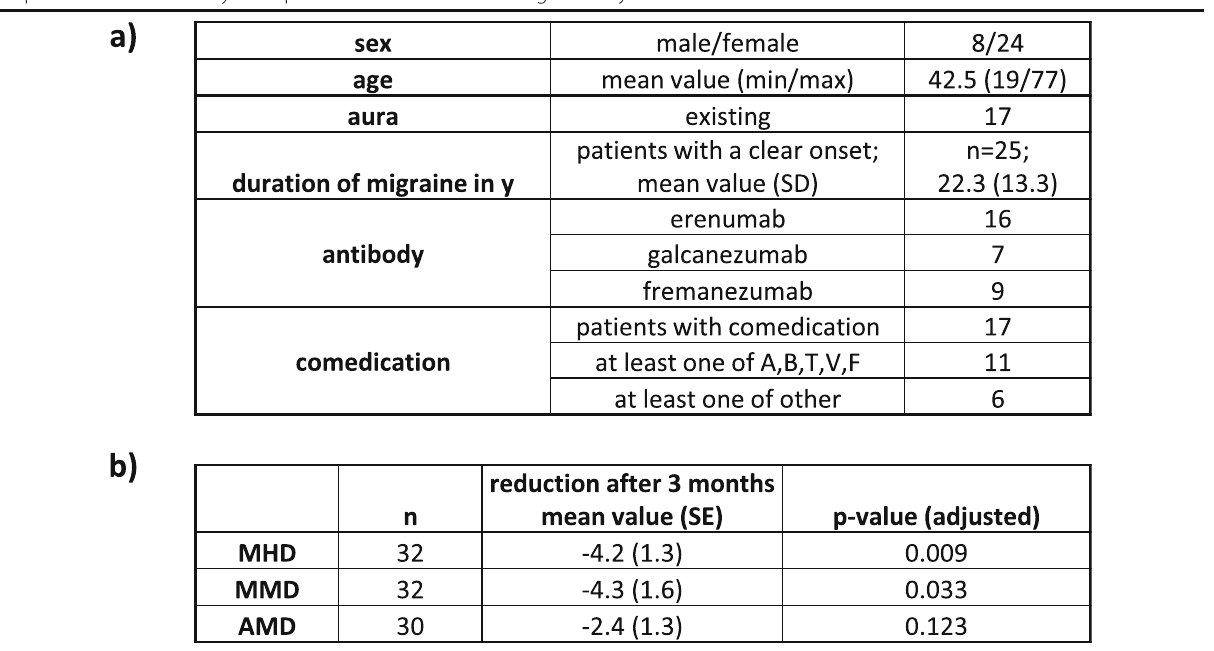
Table 1 Patients´ characteristics and statistics. a) Patients characteristics, antibody therapy and comedication. A comedication of several medication was possible. Comedication: A: amitriptyline, B: betablocker, T: topiramate, V: valproic acid, F: flunarizine, others: magnesium and other antidepressive drugs like selective serotonine reuptake inhibitors). b) changes in monthly headache days (MHD) and monthly migraine days (MMD) and monthly acute medication intake (AMD) after 3 months of treatment after the respective CGRP antibody therapie. MHD and MMD were significantly reduced after 3 months of